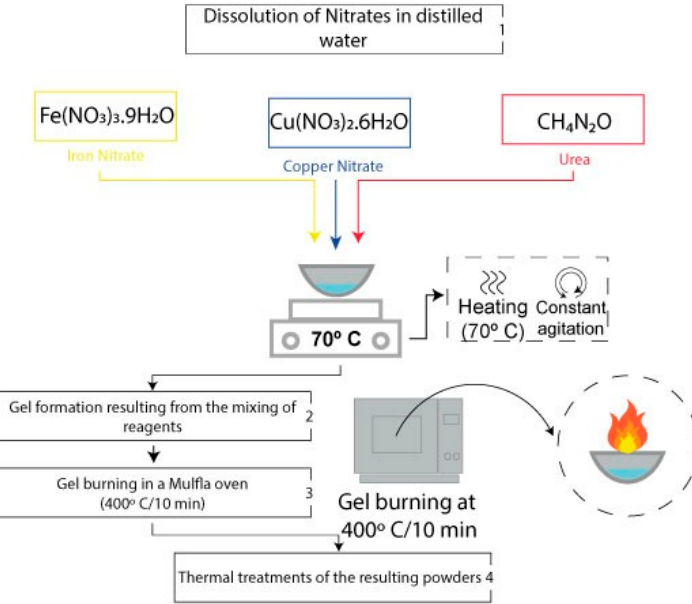
Figure 1. A flowchart of copper ferrite solution combustion synthesis.